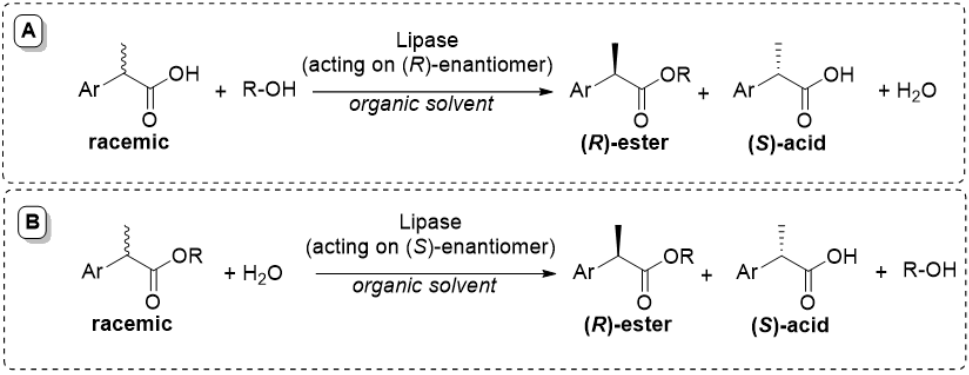
Figure 1. KR of the racemic profens leading to enantiopure ( S )-(+)-acid (eutomer): ( A ) lipase- cata- lysed esterification; ( B ) lipase-catalysed hydrolysis of the racemic profen esters.